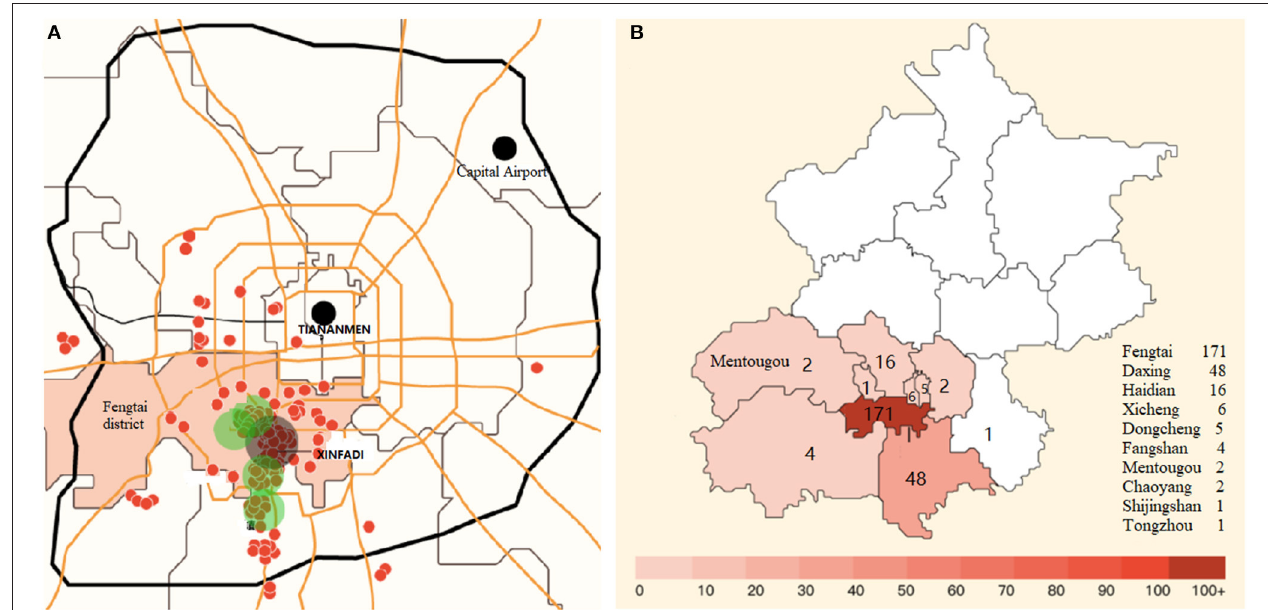
FIGURE 4 | Geographical epidemiological characteristics of confirmed cases in Beijing city. (A) Geographical distribution of all confirmed cases. (B) Spatial distribution of confirmed cases. Proportion of confirmed cases in Fengtai district was 66.8% of overall cases in Beijing. Red dots represent spatial distribution of confirmed cases, and green dots stand for the top five concentrated communities of confirmed